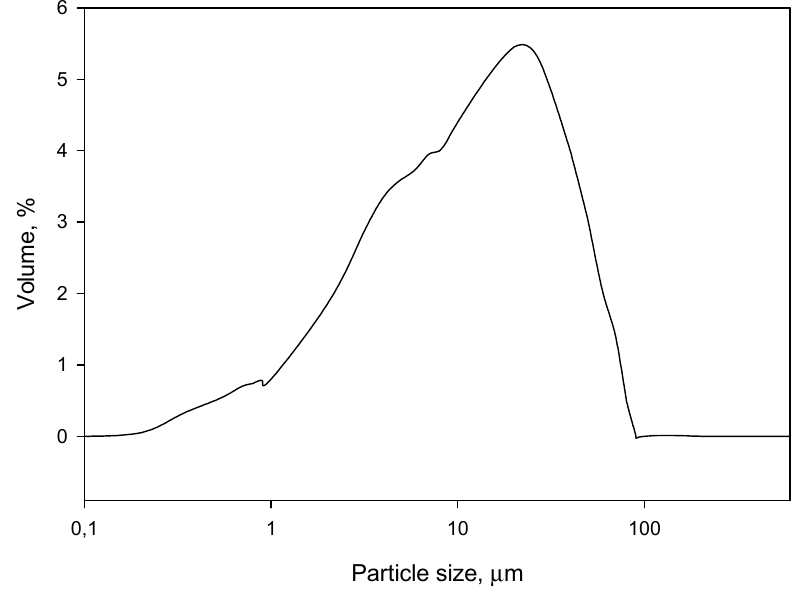
Figure 1. The particle size